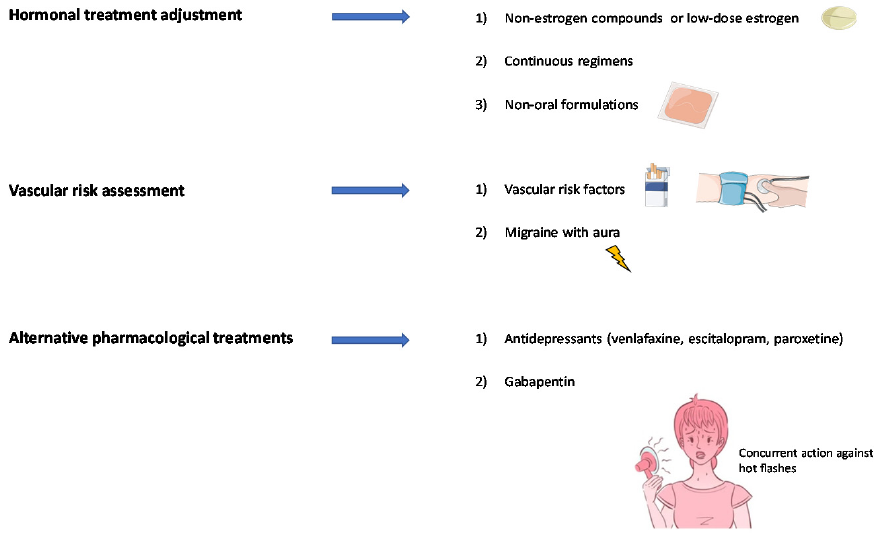
Figure 5. Suggestions for the treatment of perimenopausal migraine in clinical